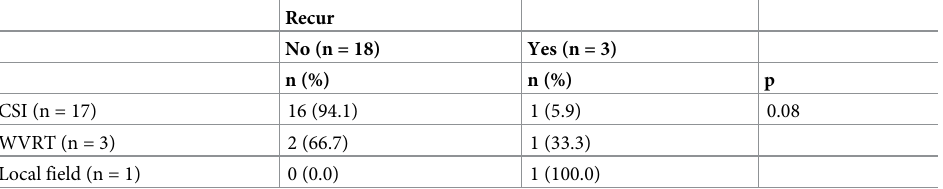
Table 3. Recurrences according to RT field. Recurrences according to cranio-spinal irradiation, whole ventricular radiotherapy and local field radiotherapy. Recur No (n = 18)